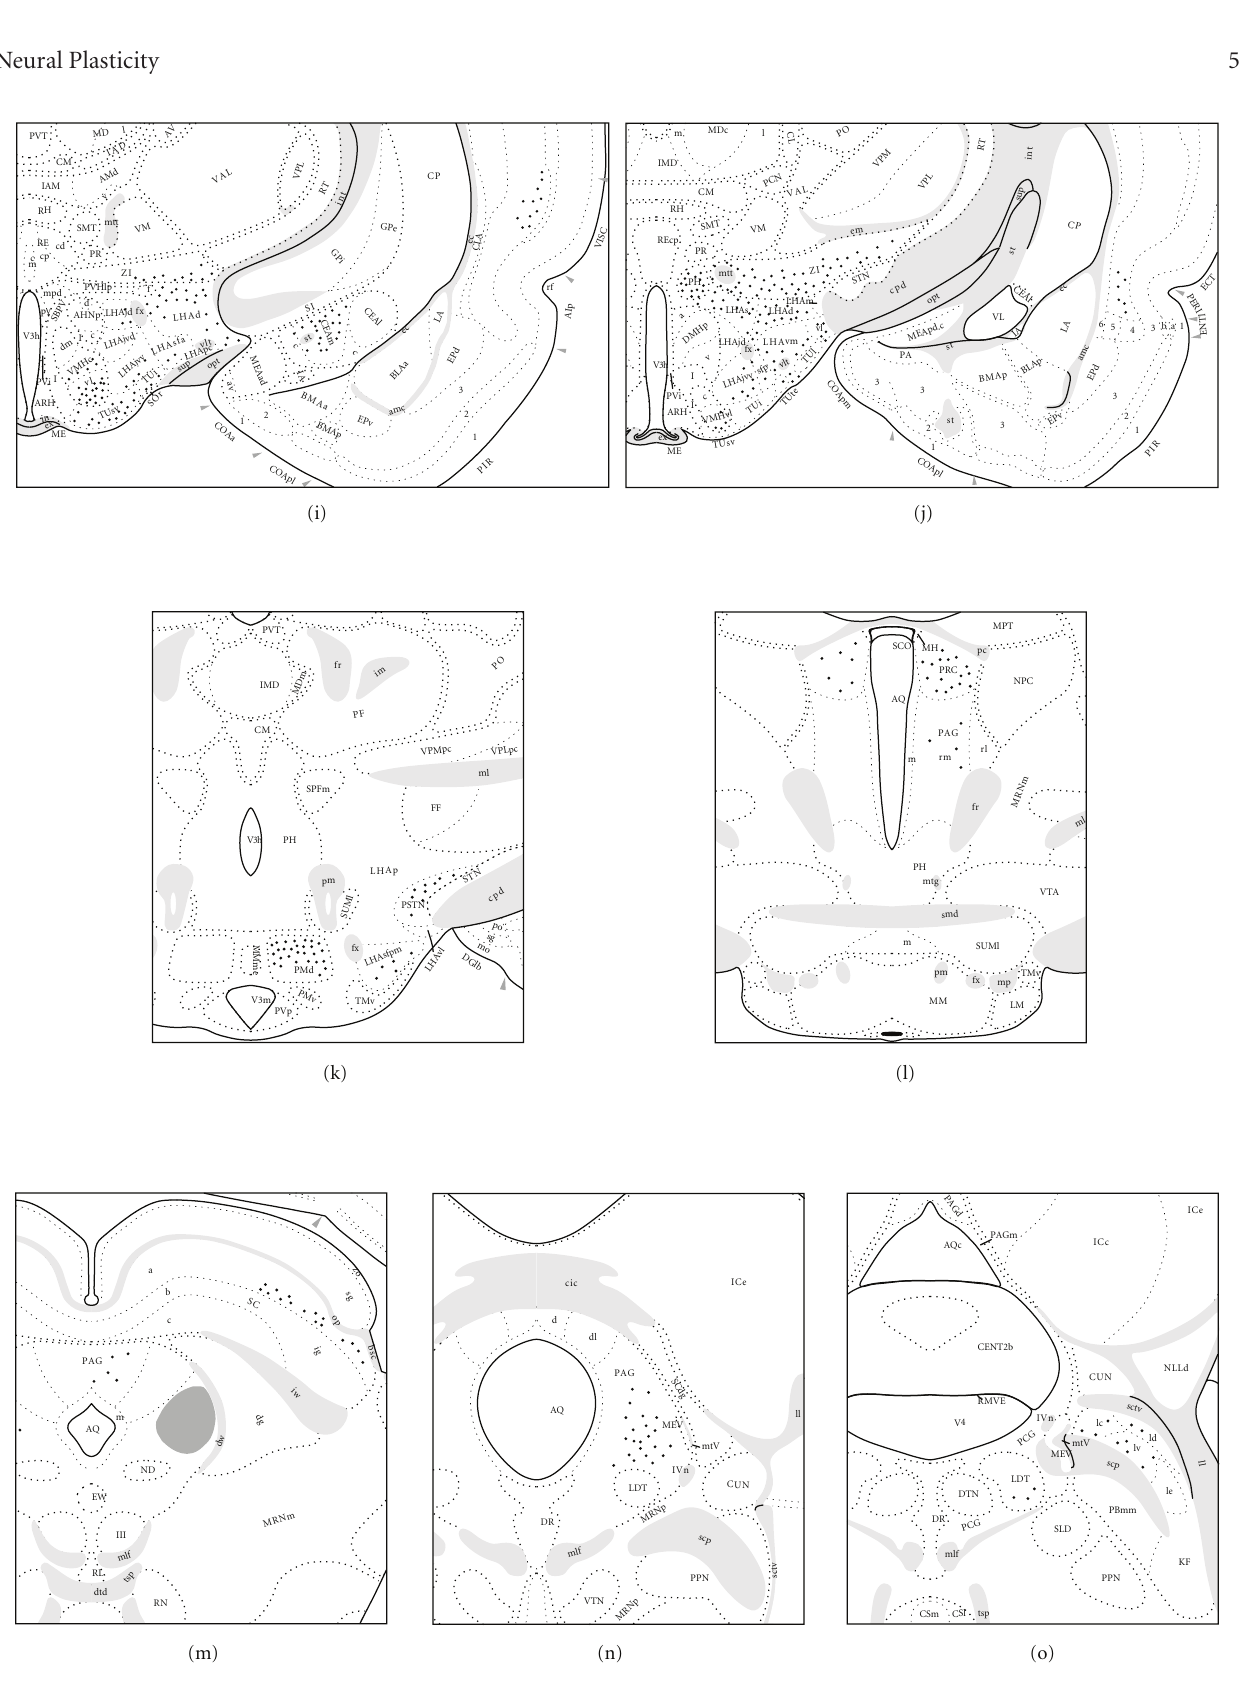
Figure 2: Inputs to the rlPAG. The distribution of retrogradely labeled neurons (black dots) in experiment PAGlFG15 plotted onto a series of standard drawings of the rat brain arranged from the rostral (a) to caudal (o) levels. The dark gray area indicates the FG injection site in this experiment. For abbreviations, see Supplementary Material available online at